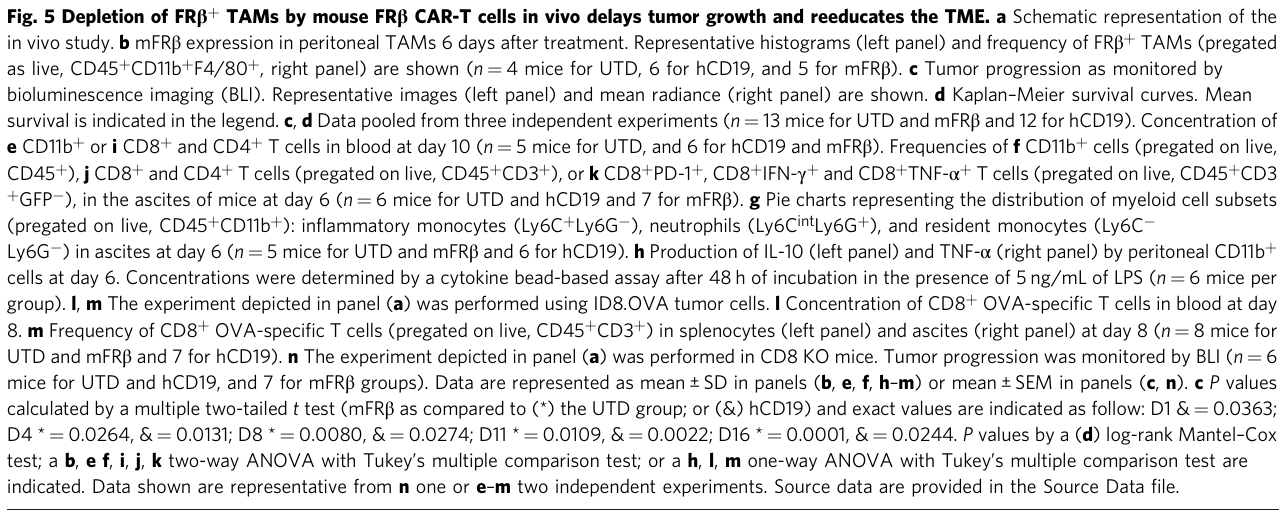
Fig. 5 Depletion of FR β + TAMs by mouse FR β CAR-T cells in vivo delays tumor growth and reeducates the TME. a Schematic representation of the in vivo study. b mFR β expression in peritoneal TAMs 6 days after treatment. Representative histograms (left panel) and frequency of FR β + TAMs (pregated as live, CD45 + CD11b + F4/80 + , right panel) are shown ( n = 4 mice for UTD, 6 for hCD19, and 5 for mFR β ). c Tumor progression as monitored by bioluminescence imaging (BLI). Representative images (left panel) and mean radiance (right panel) are shown. d Kaplan – Meier survival curves. Mean survival is indicated in the legend. c , d Data pooled from three independent experiments ( n = 13 mice for UTD and mFR β and 12 for hCD19). Concentration